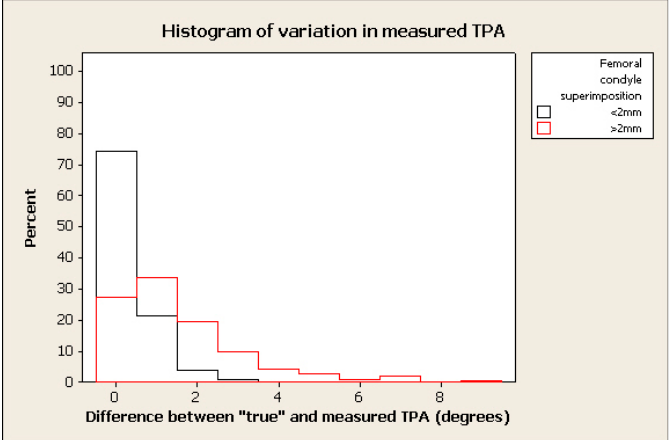
Figure 3. Histogram of frequency of measurements of TPA measured with femoral superimposition with 0 mm in difference between “true” and measured TPA in black and >0 mm in red.